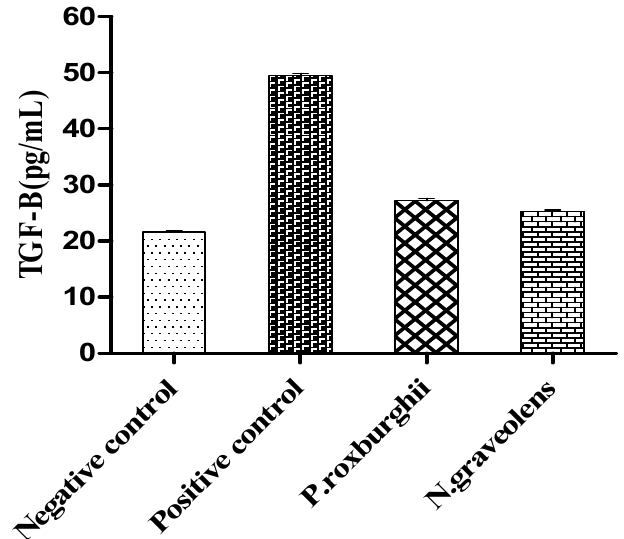
Figure 8. Level of serum TGF- β in different groups.